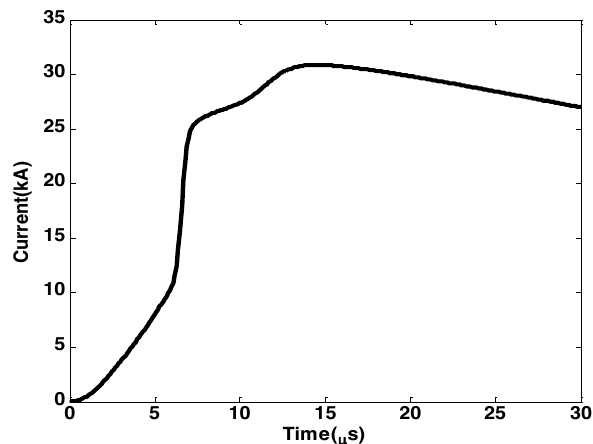
Figure 12: First stroke current used in the third example. adapted from [10].